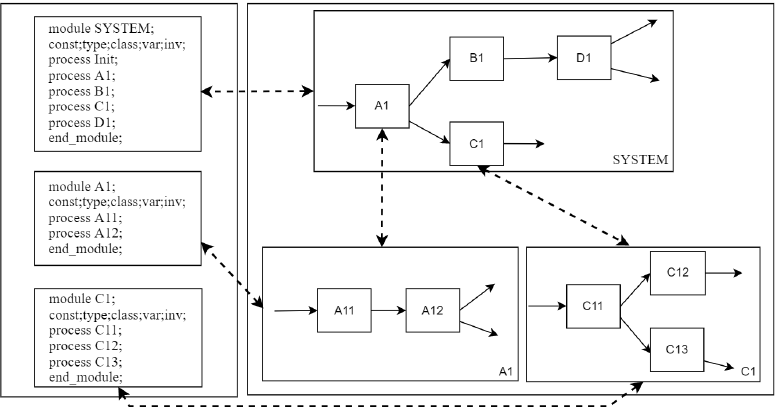
Figure 2. The framework of a SOFL